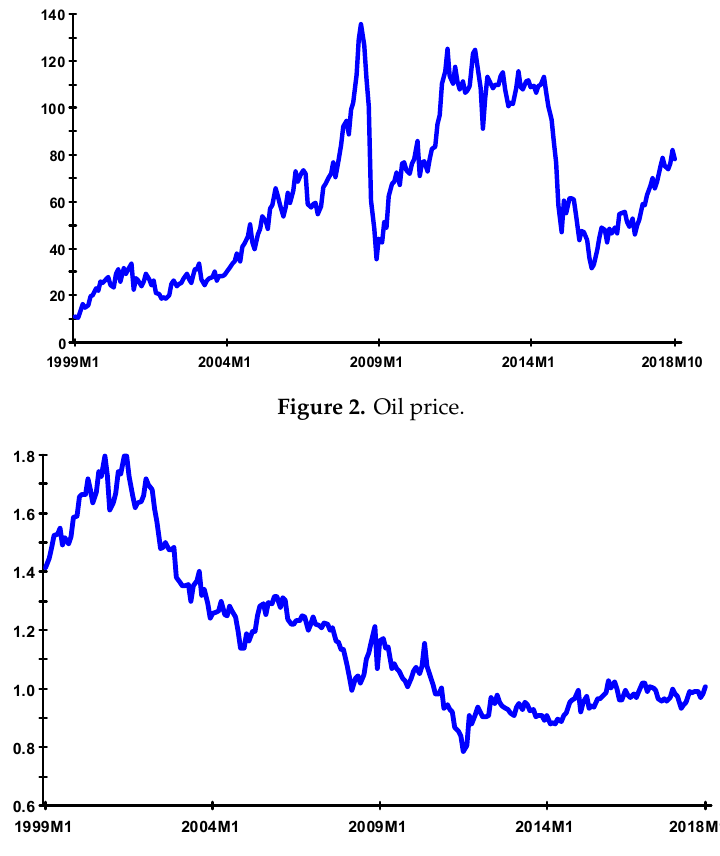
Figure 3. Swiss Franc/USD exchange rate.